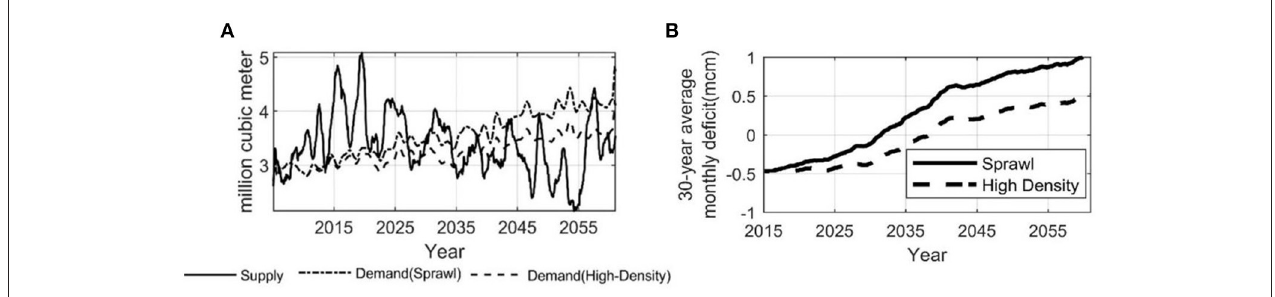
FIGURE 2 | (A) 12-month average of estimated water supply and water demand; and (B) 30-year average of monthly water deficit in million cubic meters (mcm) under the hot-dry climate model.